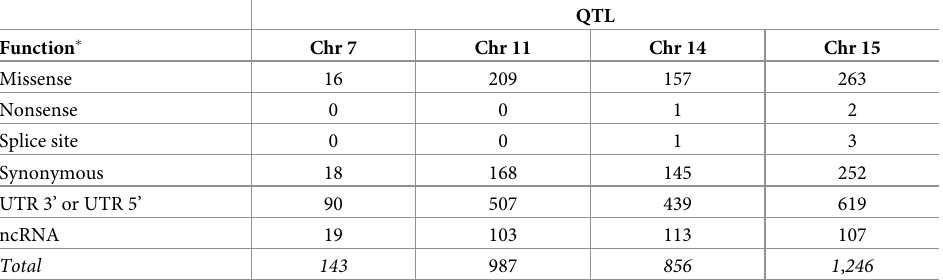
Table 2. Polymorphic exonic rare variants identified through sequencing, stratified by function �